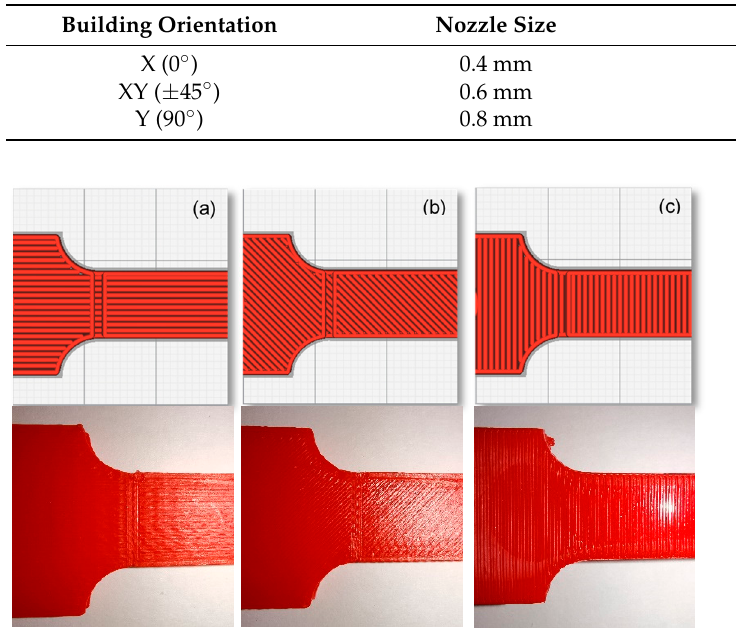
Figure 1. Building orientations directions and angles: ( a ) X (0°); ( b ) XY (± 45°); and ( c ) Y (90°) [33].